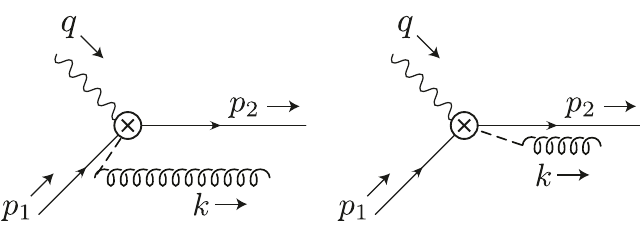
Figure 5 . Overlap subtraction graphs for producing a (cid:12)nal-state